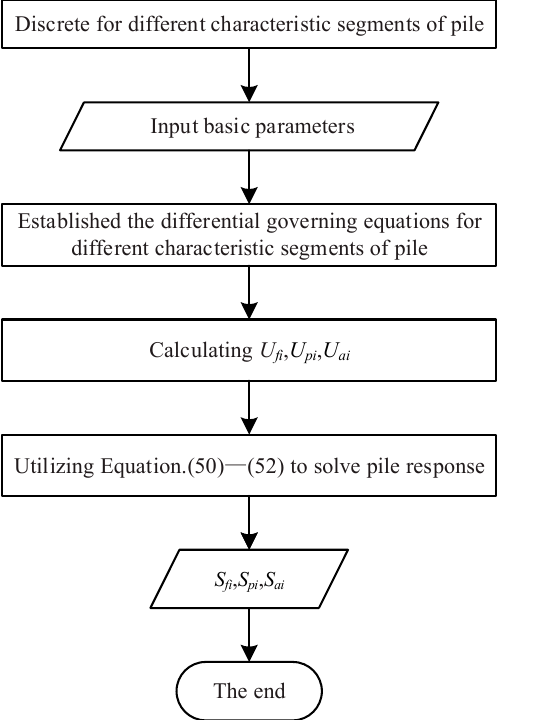
Figure 7. Algorithm to estimate pile response under combined loads with the transfer matrix ap- proach.